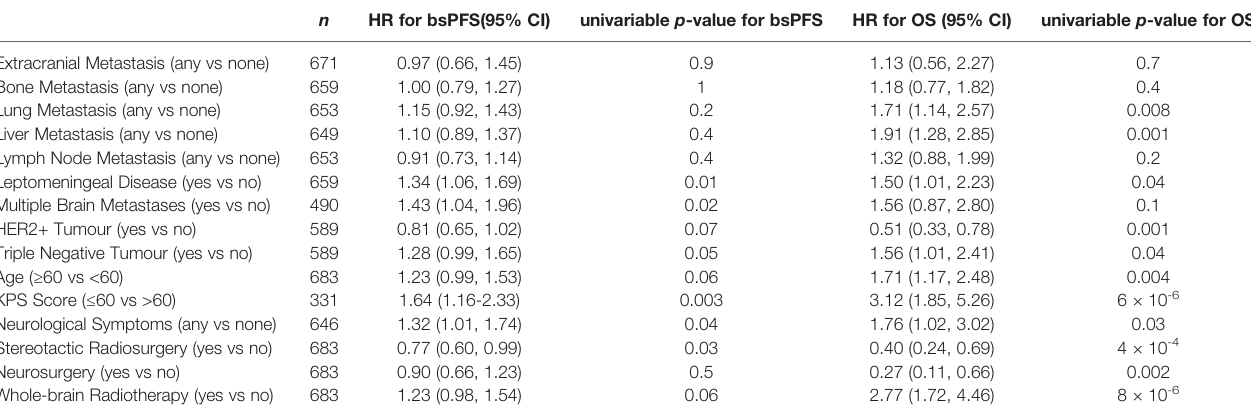
TABLE 2 | Cohort sizes and effect on hazard ratio ( “ HR ” ) for overall survival ( “ OS ” ) and brain-speci fi c progression-free survival ( “ bsPFS ” ) for all explanatory variables studied.